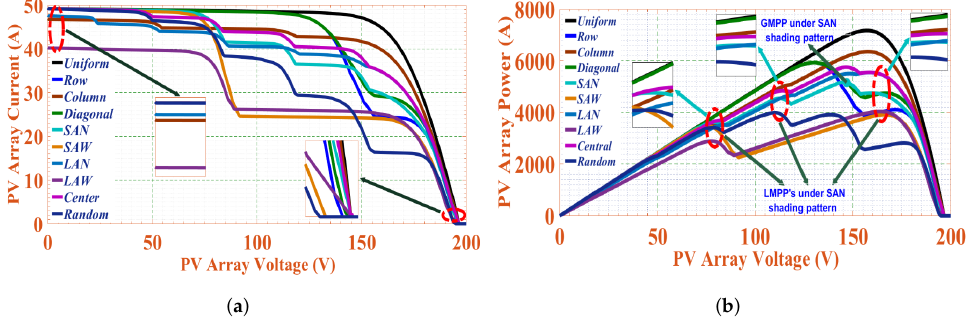
Figure 5. Results of S-P topology under various PSCs. ( a ) I-V characteristics, and ( b ) P-V characteristics.